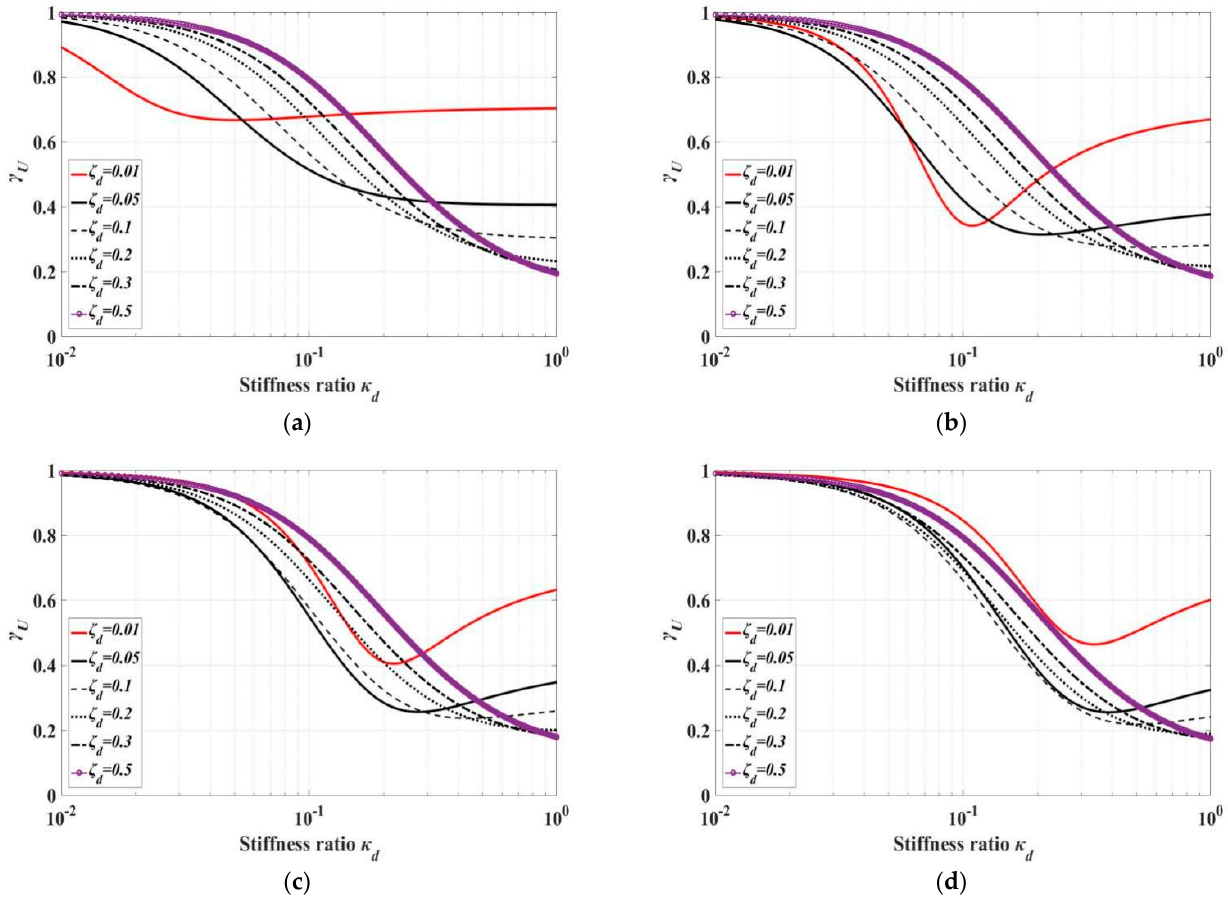
Figure 13. γ U of SC system: ( a ) μ d = 0.03; ( b ) μ d = 0.1; ( c ) μ d = 0.2; and ( d ) μ d = 0.3.